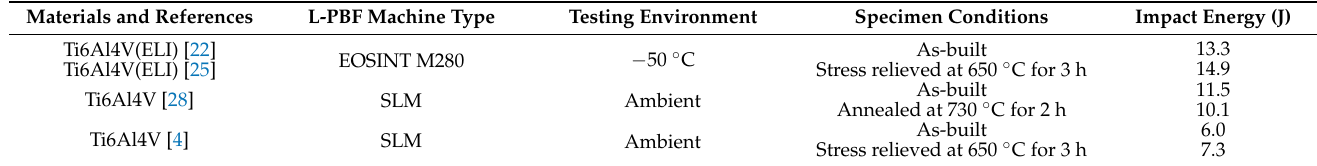
Table 3. Impact toughness values of Ti6Al4V(ELI) specimens built by the L-PBF technique.